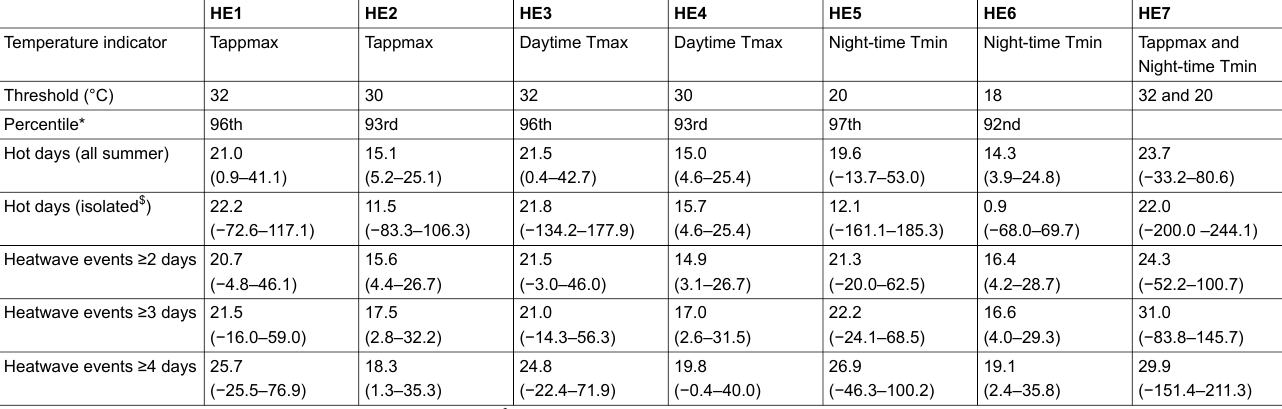
Table 3: Percent excess mortality (and 95% confidence interval) during heat episodes (HE), according to different cut-off definitions for maximum apparent temperature (Tappmax), daytime maximum temperature (Daytime Tmax) and night-time minimum temperature (Nighttime Tmin) in summer 2015.